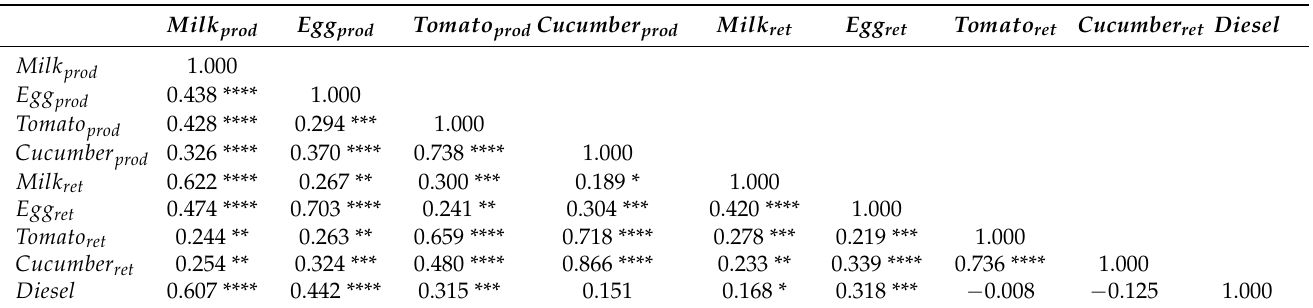
Table 2. Correlation